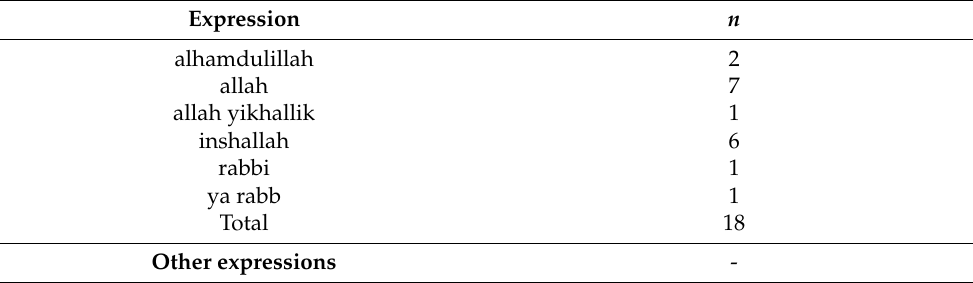
Table 9. Presenter